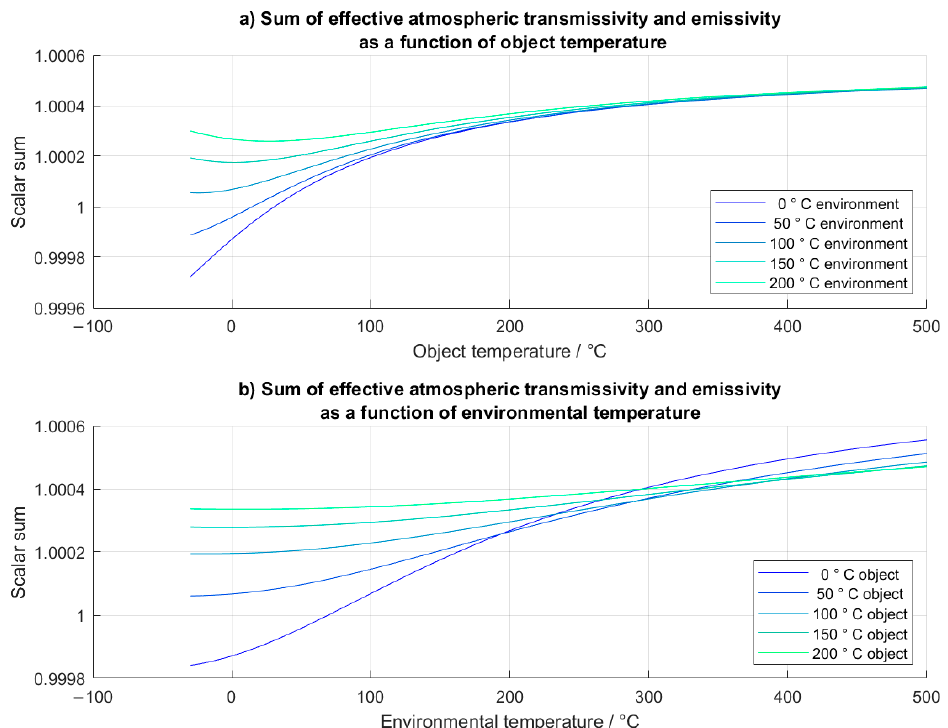
Figure 17. The sum of effective atmospheric transmissivity and emissivity with ( a ) object temperature and ( b ) environmental temperature, assuming a thermally homogeneous environment. Multiple plots show the variation of ( a ) environmental temperature and ( b ) object temperature.